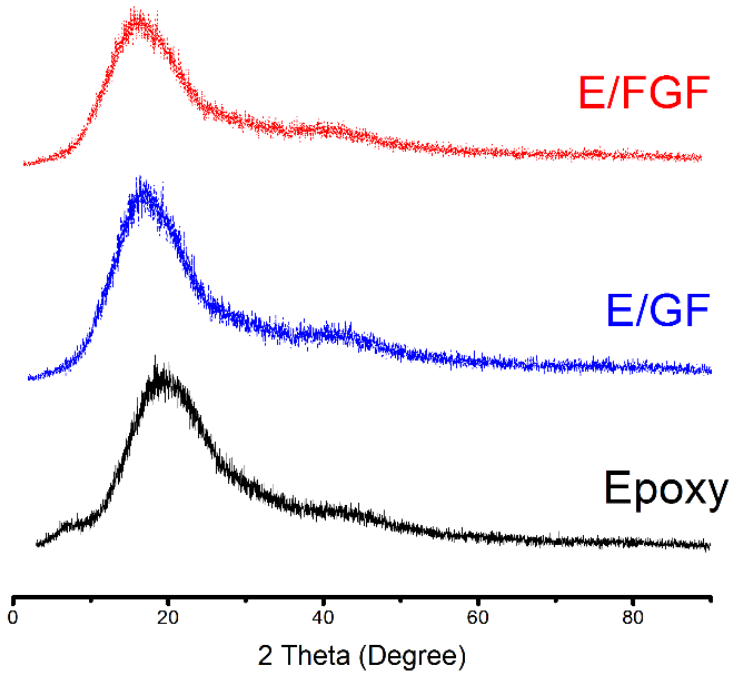
Figure 2. XRD patterns of the epoxy, E/GF, and E/FGF.